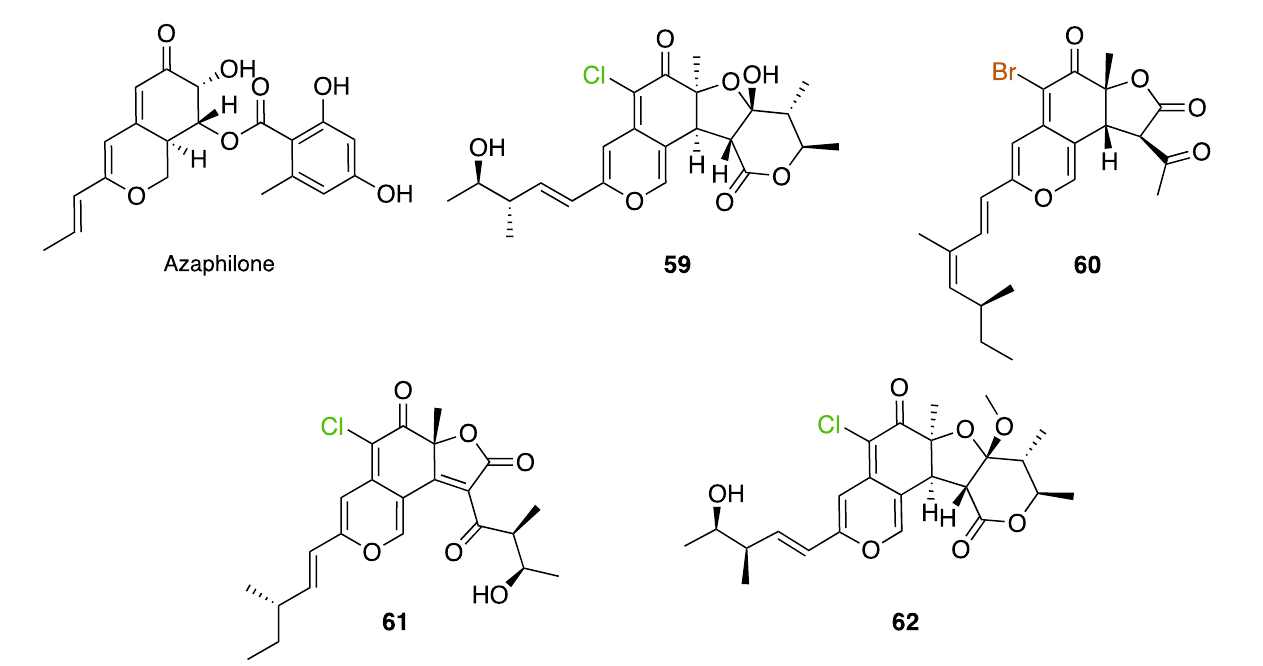
Figure 27. Representative azaphilone-type metabolites from cluster 3: 11-epichaetomugilin A ( 59 ) from Chaetomium sp.; 5-bromoochrephilone ( 60 ) from Penicillium sp.; chaetoviridin E ( 61 ) and chaetomugilin B ( 62 ) from Chaetomium sp.